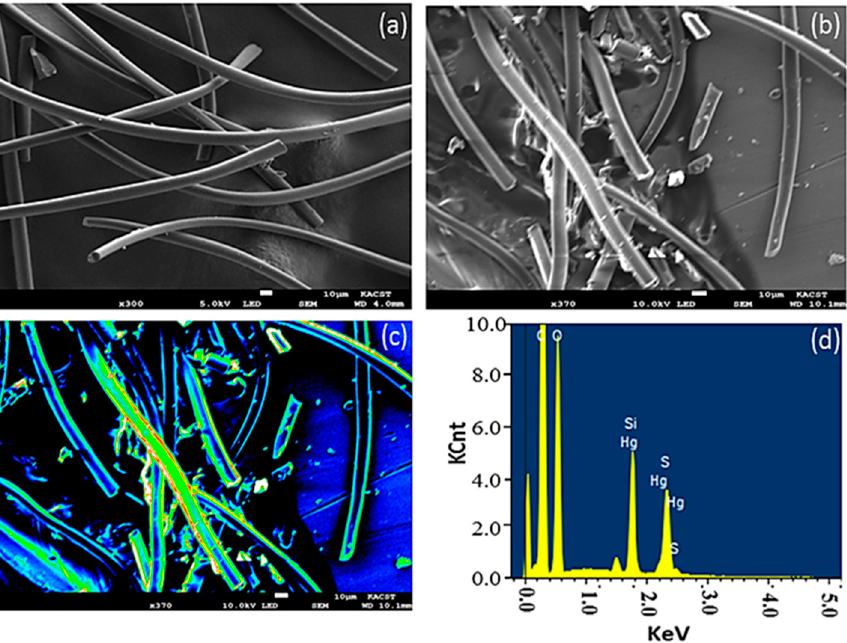
Figure 3. UV-vis absorption spectra of ( a ) CF-OH, ( b ) CF-SH, and ( c ) CF-SH-Hg.